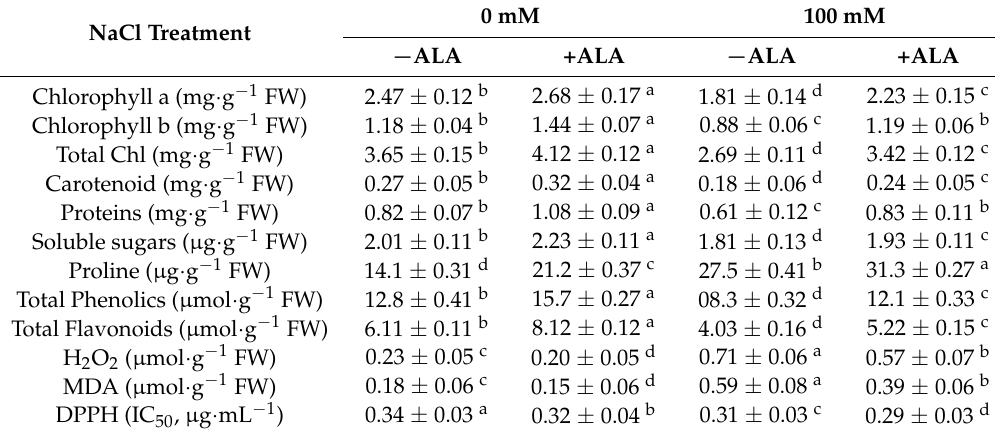
Table 8. Contents of chlorophyll, carotenoids, proteins, sugars, proline, phenolics, flavonoids, H 2 O 2 , MDA and antioxidant activity (DPPH) in leaves of Bigo cultivar under salt and/or ALA (7 ppm) treatments.